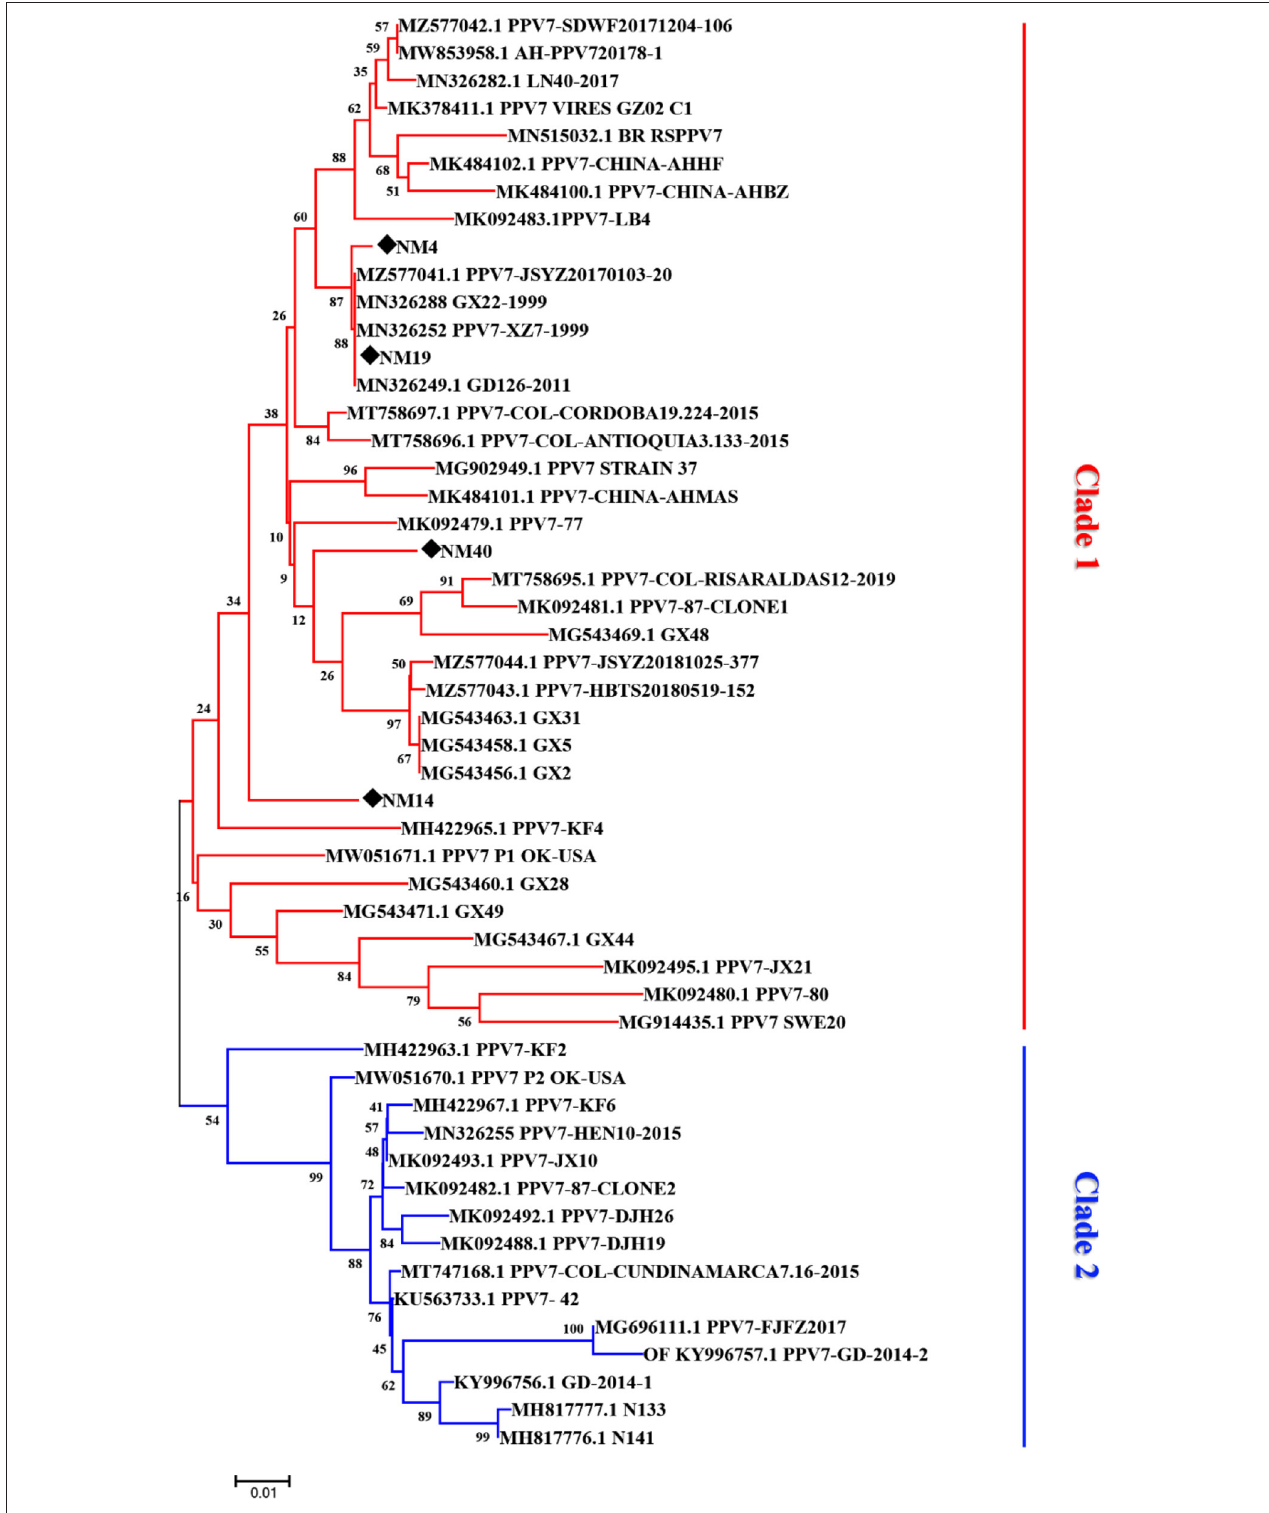
FIGURE 3 | Phylogenetic tree based on the amino acid sequences of different porcine parvovirus 7 strains. The tree reliability was assessed using the Neighbor-joining method with the Poisson model and 1,000 bootstrap replications. The strains detected in our laboratory are marked with a black solid diamond.